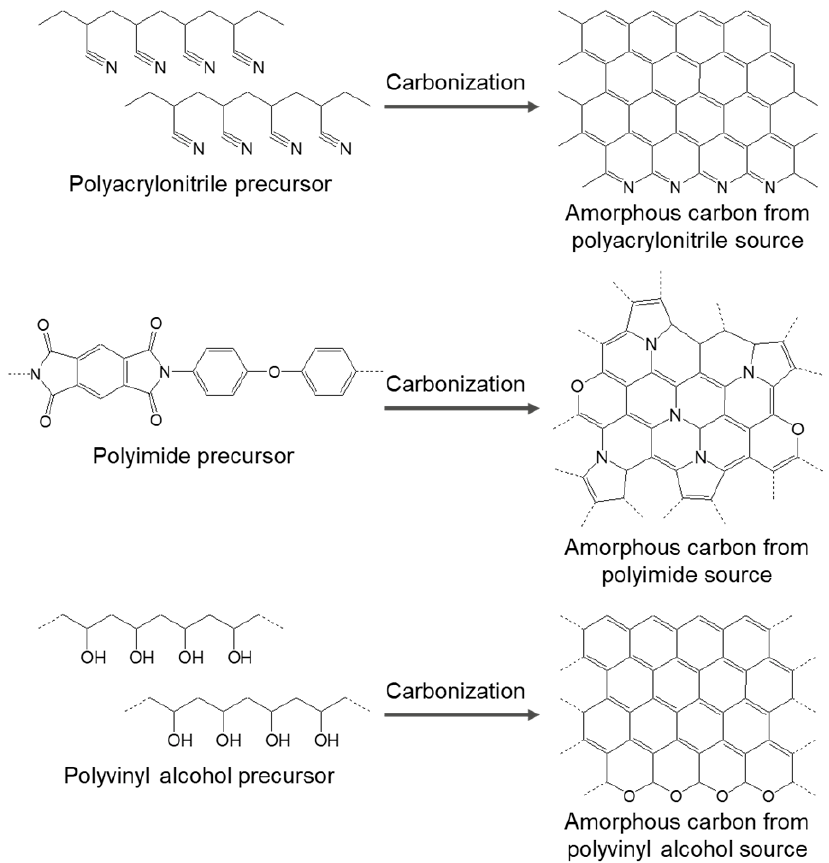
Figure 5. Chemical structures of amorphous carbon after carbonization polyacrylonitrile, polyimide, polyvinyl alcohol precursor, respectively.